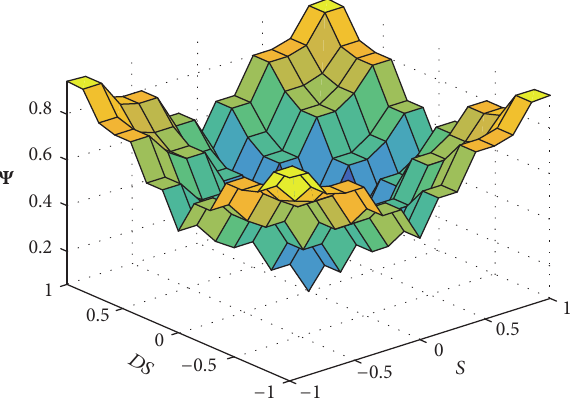
Figure 7: Surface of the fuzzy rules. Table 1: Fuzzy inference rules of fuzzy controller.